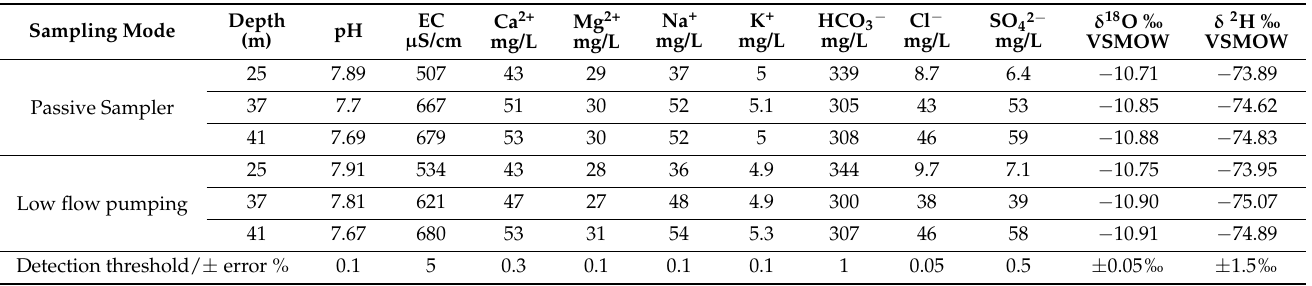
Low flow pumping Detection threshold/ ± error